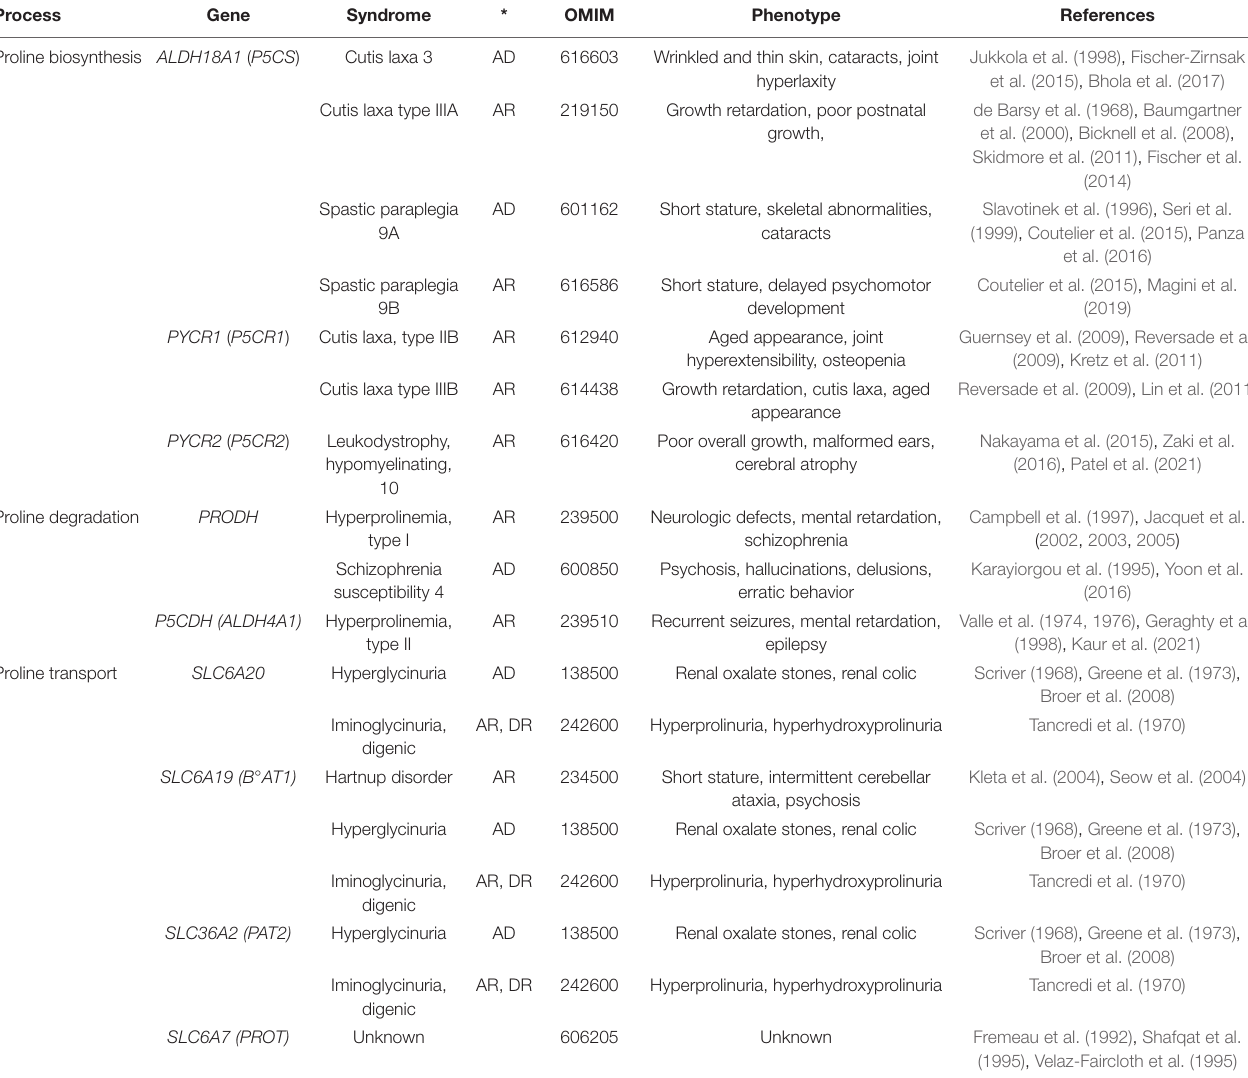
TABLE 2 | Diseases associated with defects in genes involved in the proline metabolism.